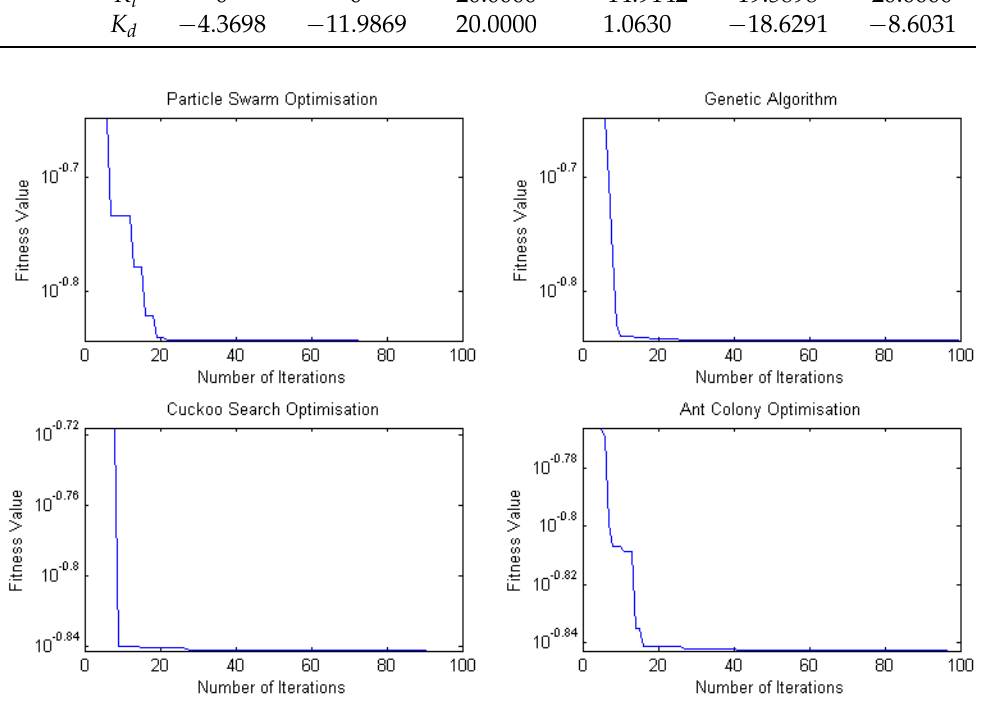
Figure 6. The change in fitness over the number of iterations (generations). The performance of these controllers is evaluated for tracking elevation around the trim height, i.e., z d = − 10 ± 1 metres and unit steps wind gust for y at t = 7 s. Figures 7 and 8 show a visual comparison of the controllers. The ACO-PID is superior to others, although the others are also within the performance